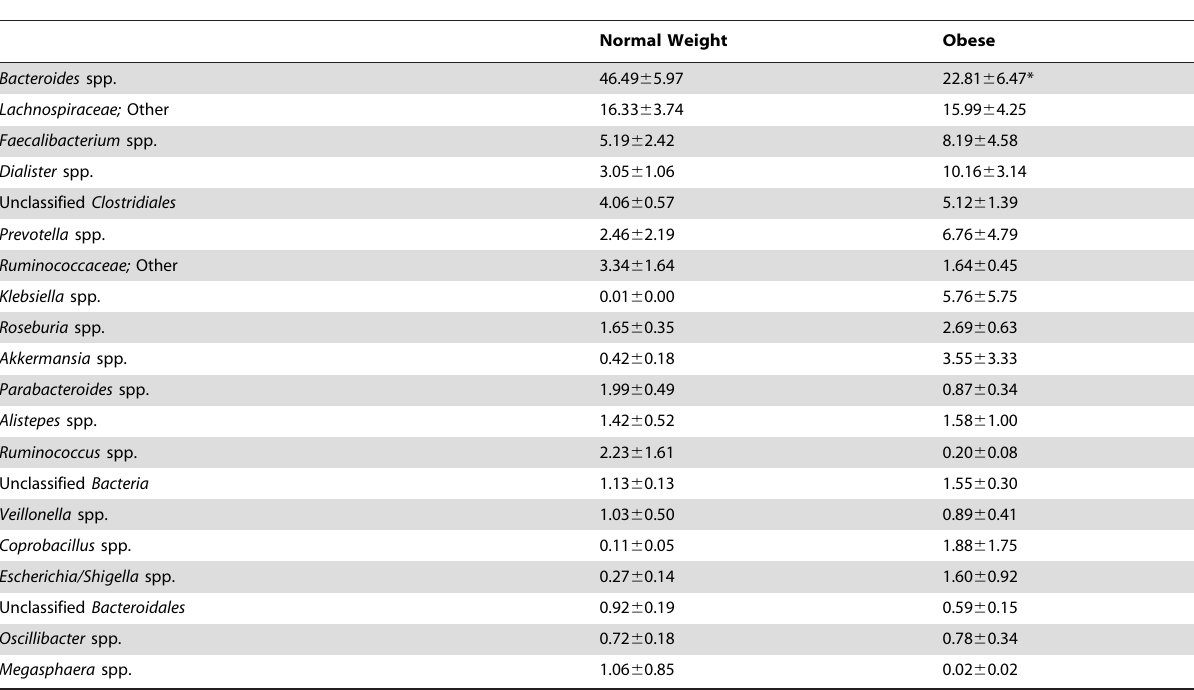
Table 5. Top 20 Most Abundant Genera Among Low-Income Subjects.